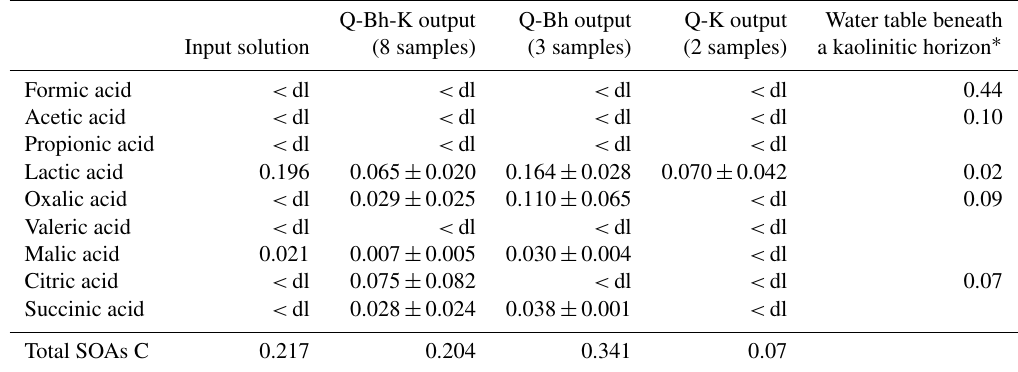
Table 4. Concentrations ± standard deviation of small carboxylic acids in the studied solutions and from the literature. Values in milligrams of carbon per liter; < dl – lower than detection limit.